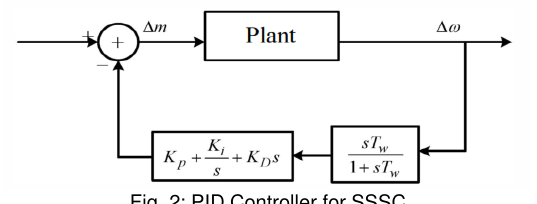
Fig. 2: PID Controller for